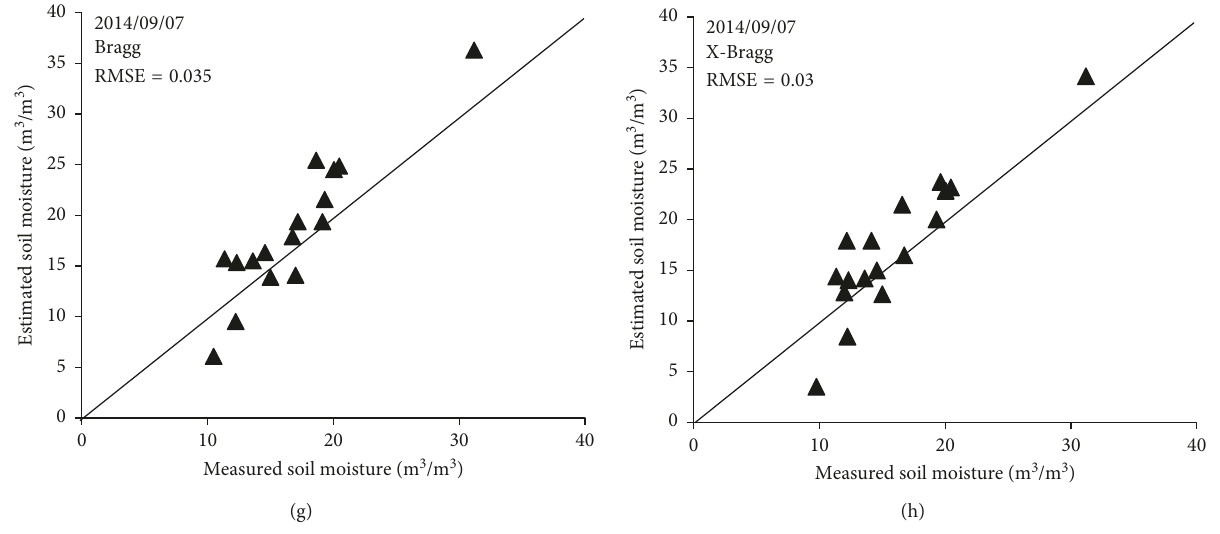
Figure 11: Accuracy of estimated soil moisture levels at different growth stages of